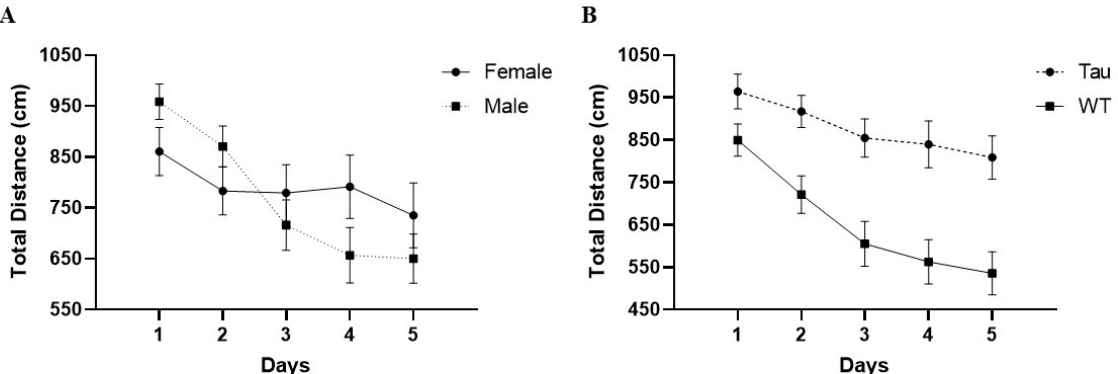
Figure 10. Total distance swam in the MWM. ( A ) As the days progressed, mice swam less total distance, with male mice specifically traveling shorter distances on days 3 through 5 compared to day 1 ( p < 0.001). Female mice did not show significant differences in distances throughout the training days. ( B ) As the days progressed, tau mice traveled a significantly greater distance than WT mice ( p < 0.001). Error bars represent mean ± SEM.